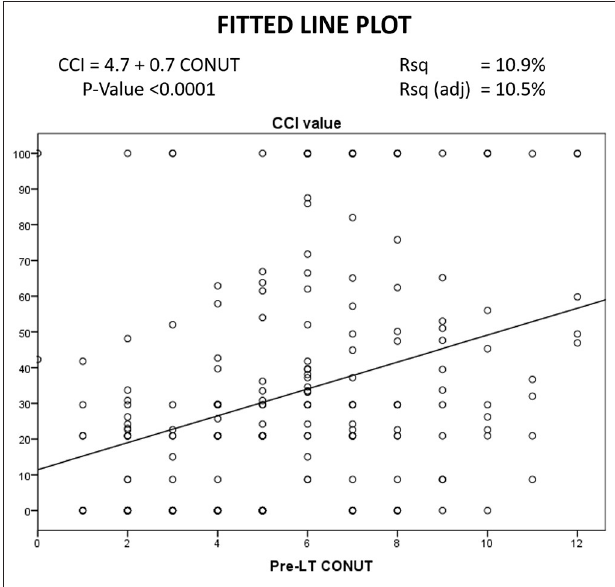
FIGURE 2 | Linear correlation between CONUT and CCI.